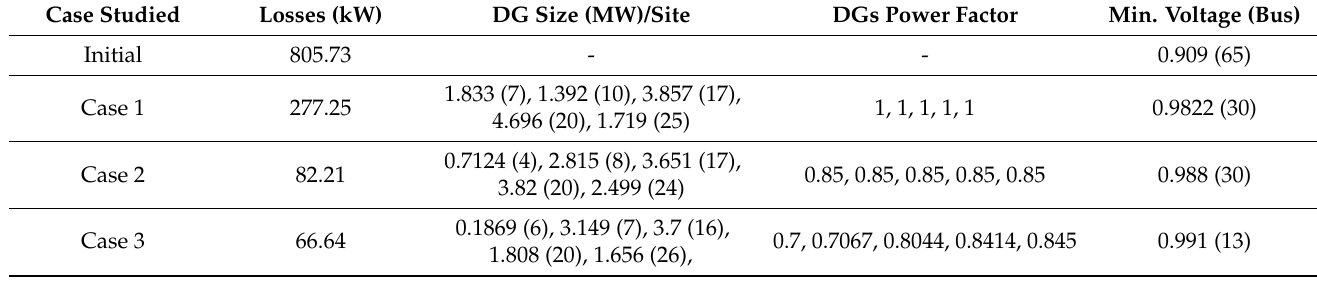
Table 2. Optimal allocation of DGs using GWO.